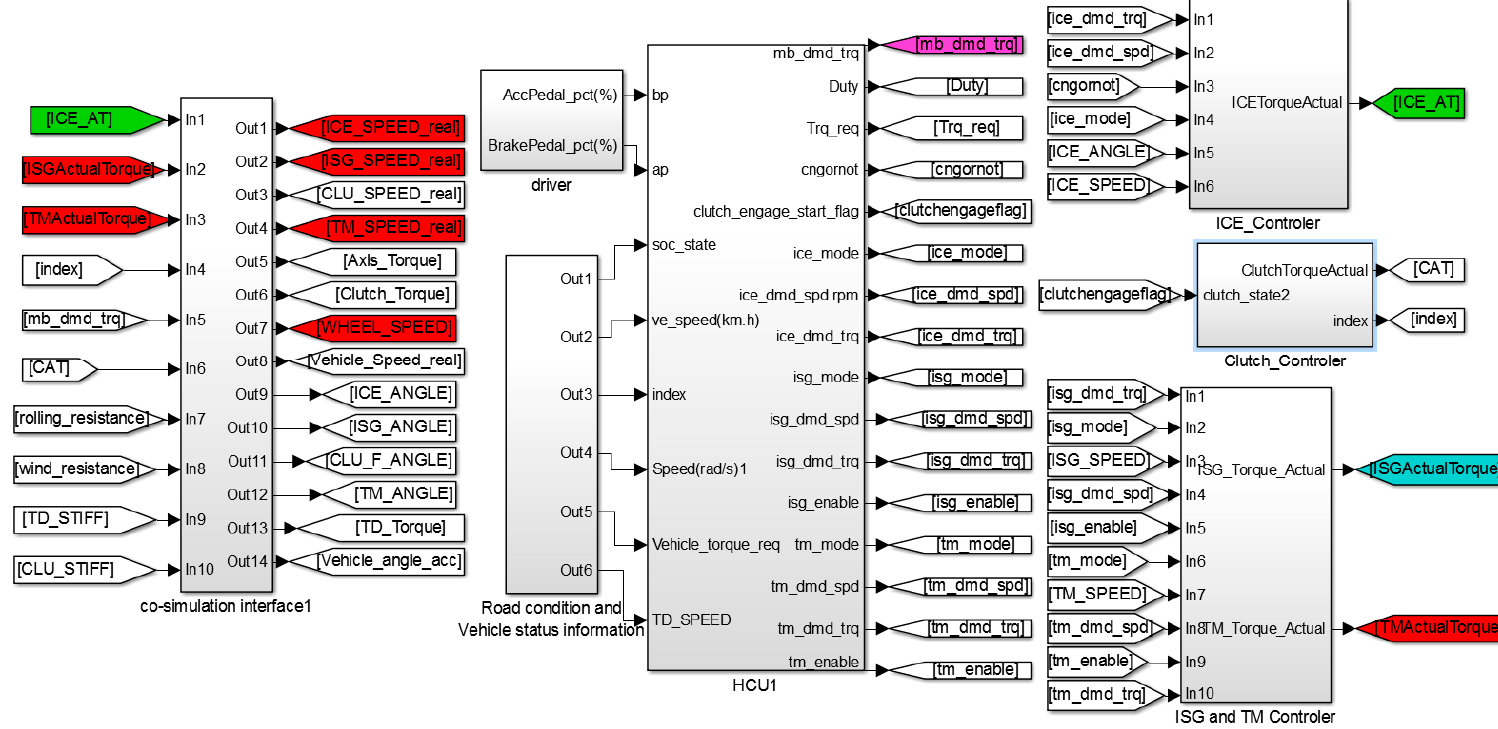
Figure A3. Active control module in Simulink.